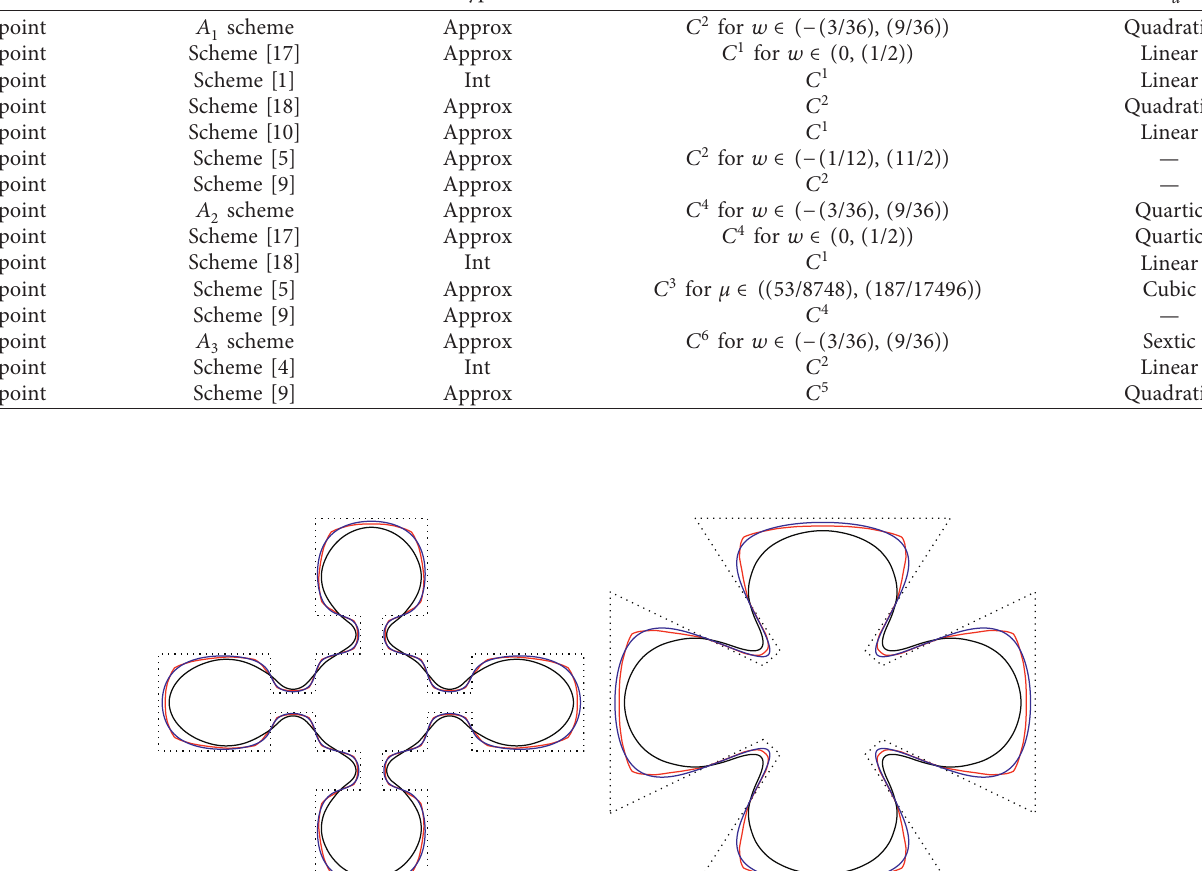
C G m , where s , C , and d are complexity, continuity analysis, and generation degree